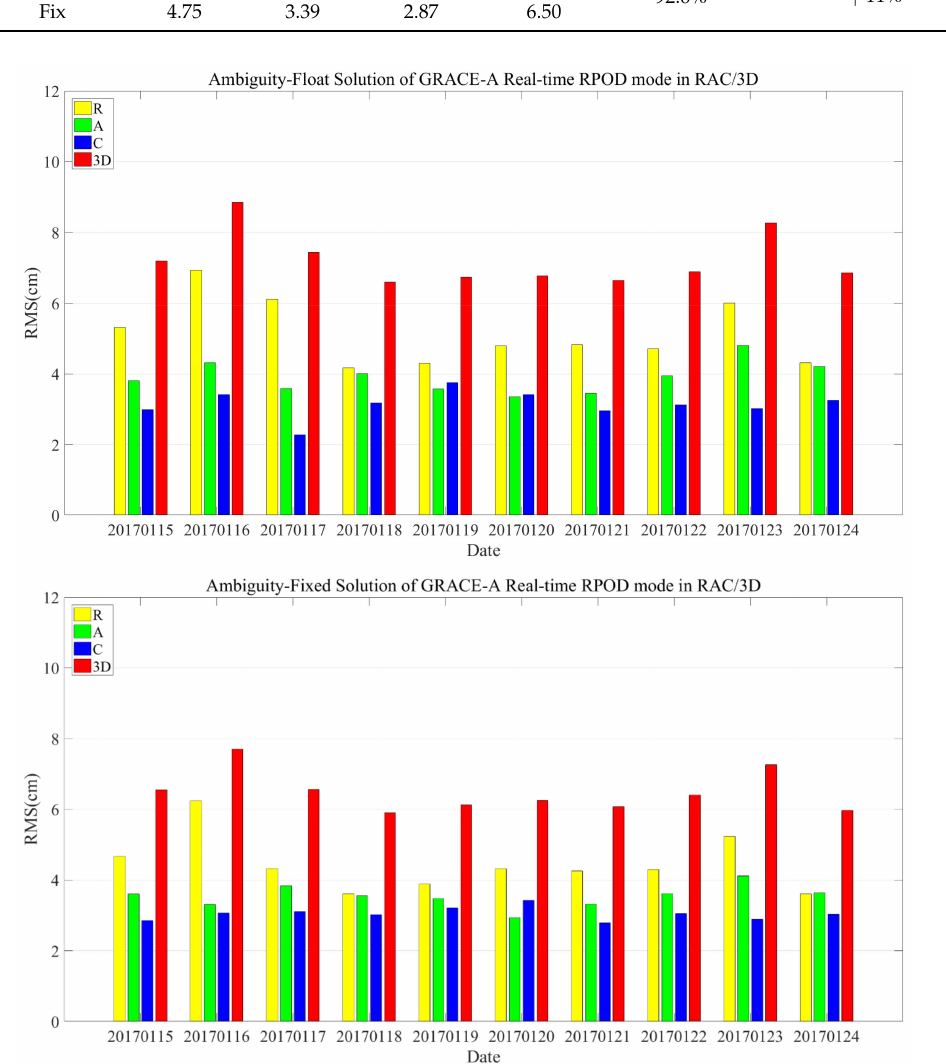
Figure 10. The accuracy (RMS) of real-time RPOD ambiguity-float ( upper ) and ambiguity-fixed ( bottom ) solution for